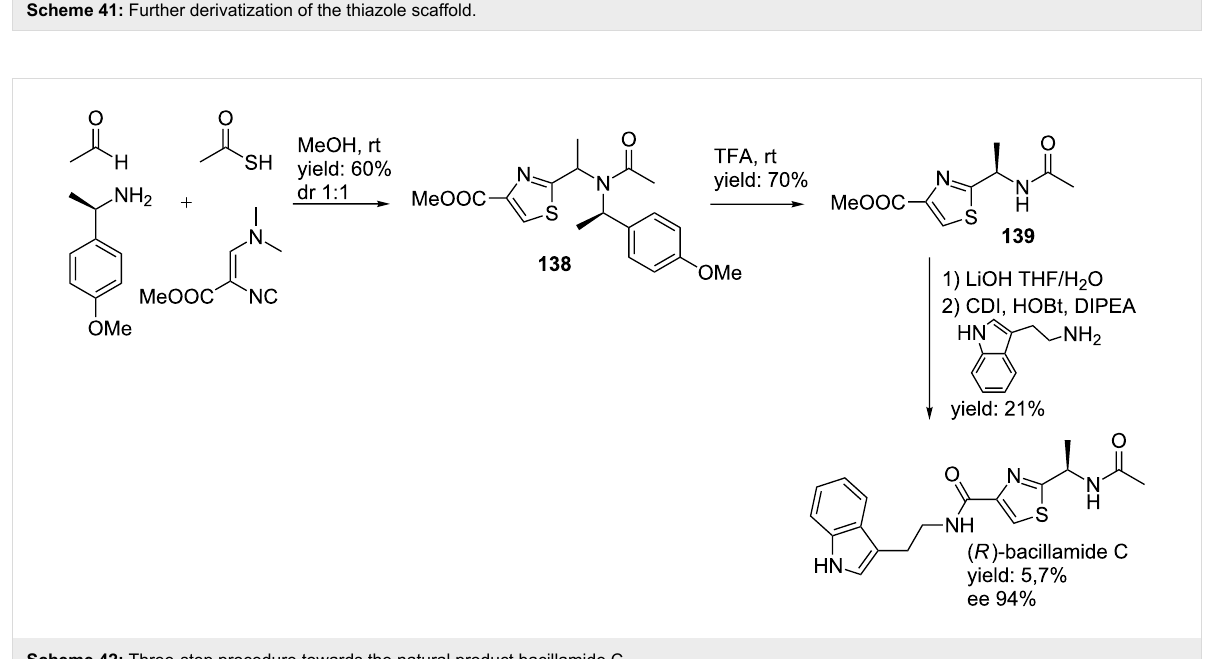
Scheme 41: Further derivatization of the thiazole scaffold.